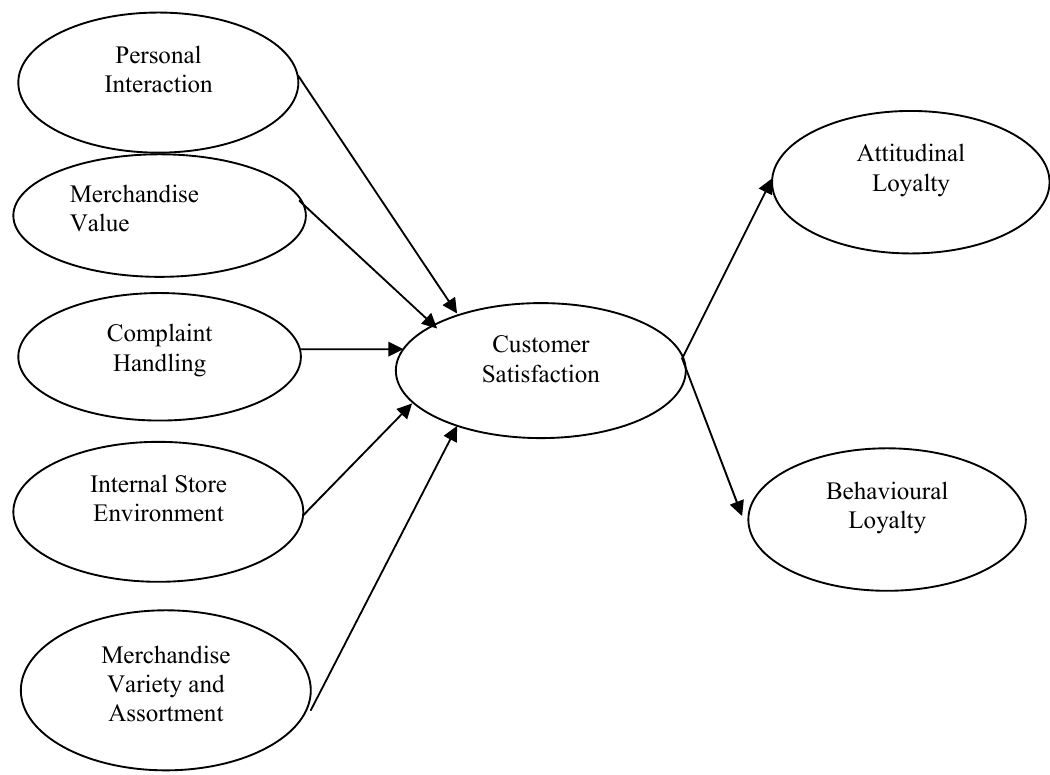
Figure 2: The theoretical model Table 2: Parameter estimates for model in Figure 2: The behavioural